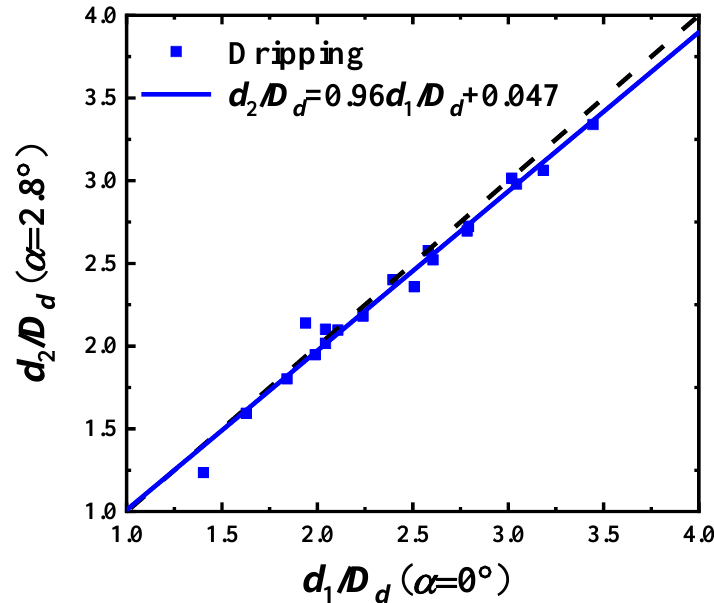
Figure 8. The correlation test of paraffin droplet sizes between d 1